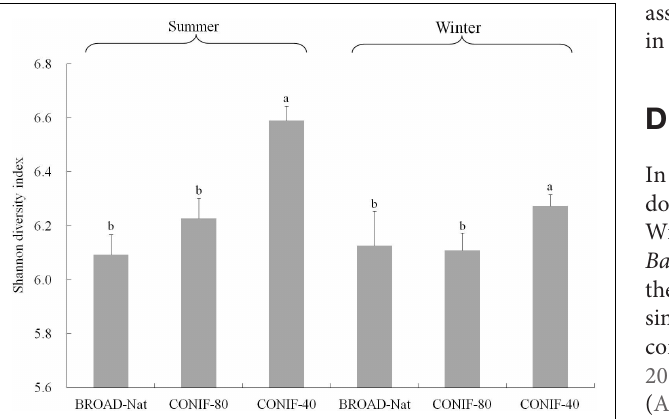
FIGURE 2 | Shannon diversity index of three forest soil bacterial communities. OTUs were calculated at the 3% evolutionary distance. Bars of the same season with different letters indicate significant differences at P ≤ 0.05 analyzed with one way ANOVA. The bacterial diversity of the same forest types between two seasons was not significantly different.